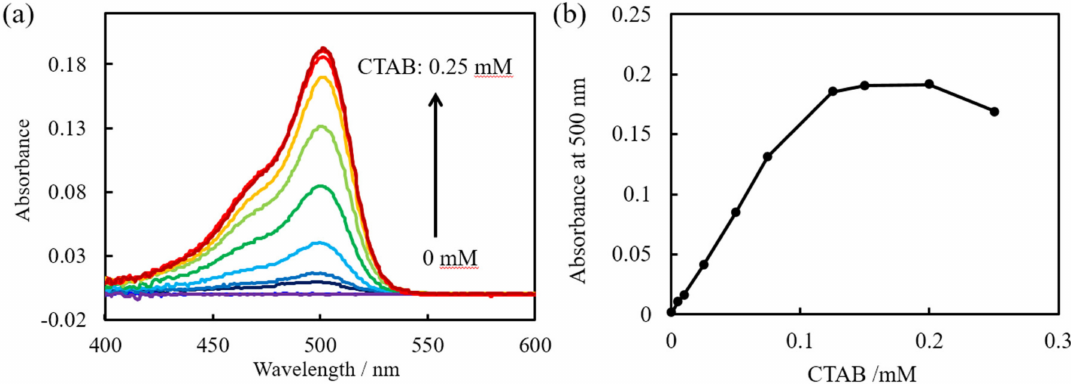
Figure 1. ( a ) Absorbance spectra of various concentrations of hexadecyltrimethylammonium bromide (CTAB) and 1 µ M uranine obtained 300 s after mixing by the fiber optic sensor prepared in this study. ( b ) Absorbance at 500 nm as a function of CTAB